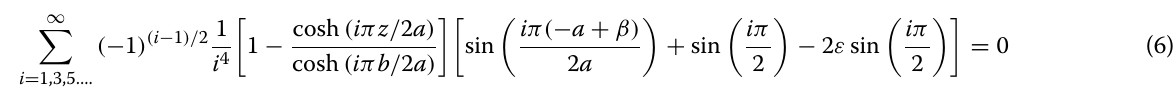
0, 0.5 b , and 0.75 b . (iii) Color map of the laminar = ± ±